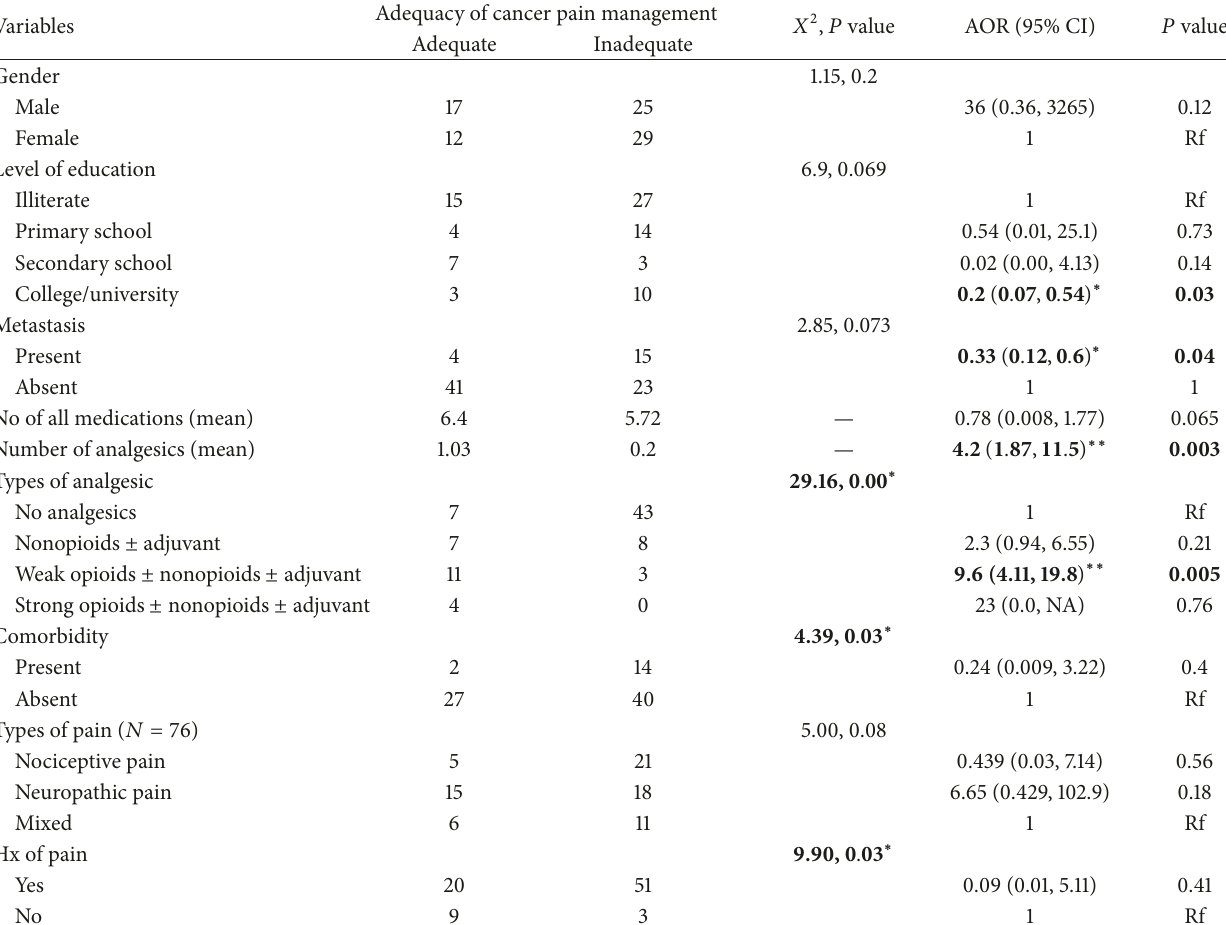
Table 3: Relationship between predictive variables and adequacy of cancer pain management at Gondar University Hospital, Gondar,